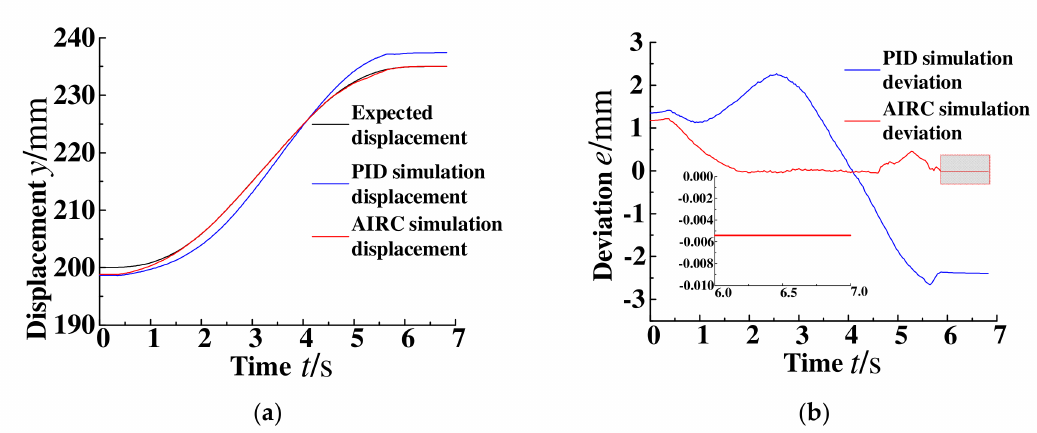
Figure 13. System displacement and deviation curve under working condition 3 (cid:13) . ( a ) System displacement curve. ( b ) System displacement deviation